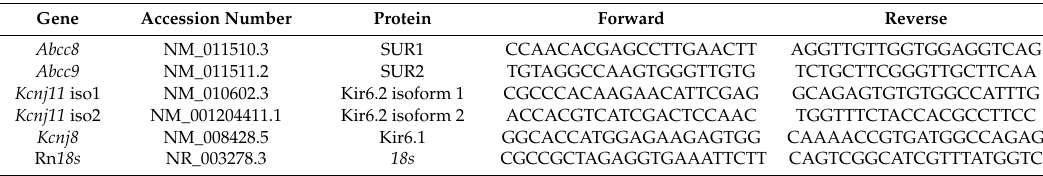
Table 1. Primers used in quantitative PCR